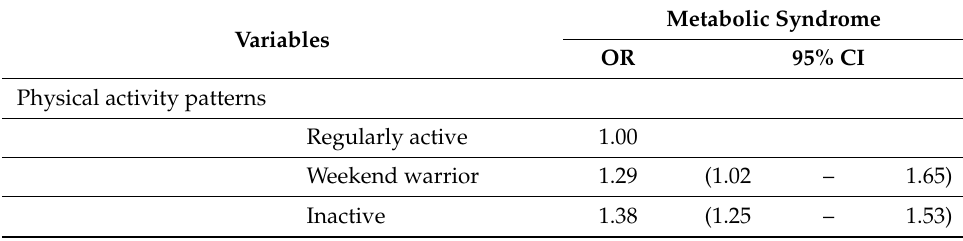
Table 2. Results of factors associated between physical activity patterns and metabolic